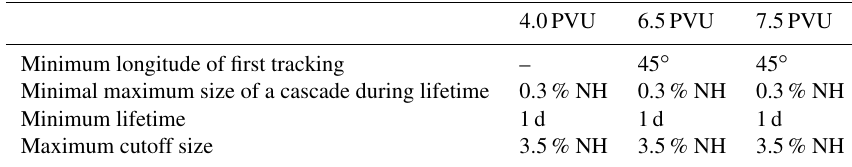
Table 1. Used filter criteria for the cutoffs in the ASMA region, based on the case